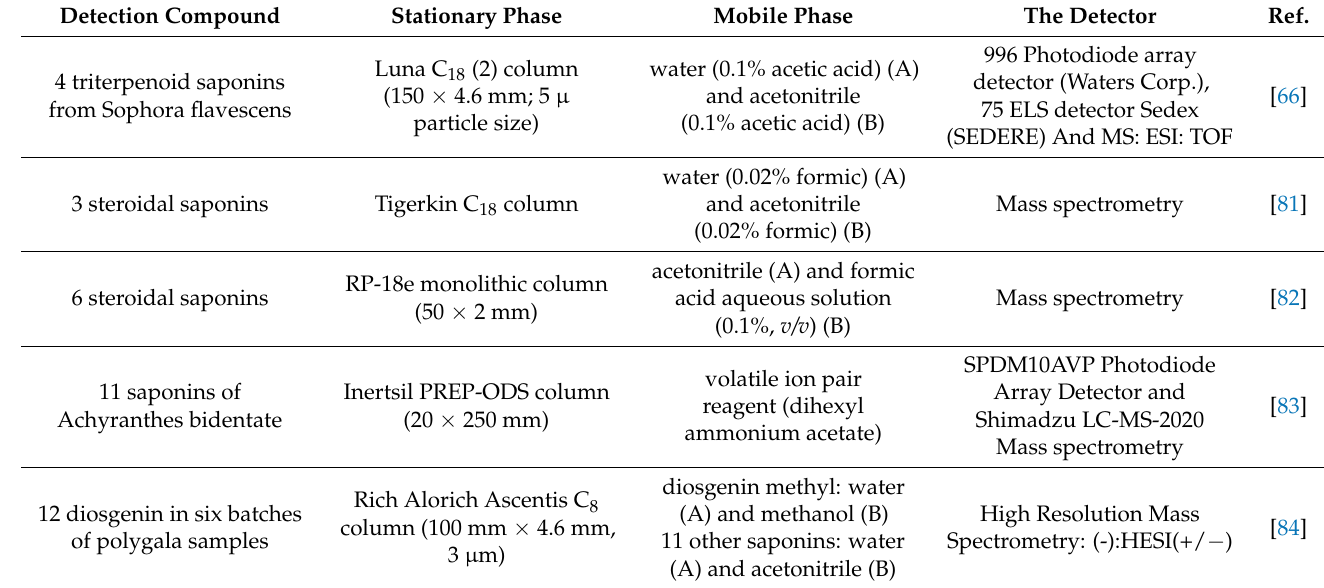
Table 3. Detailed conditions for the analysis of saponins in natural medicines and foods by high- performance liquid